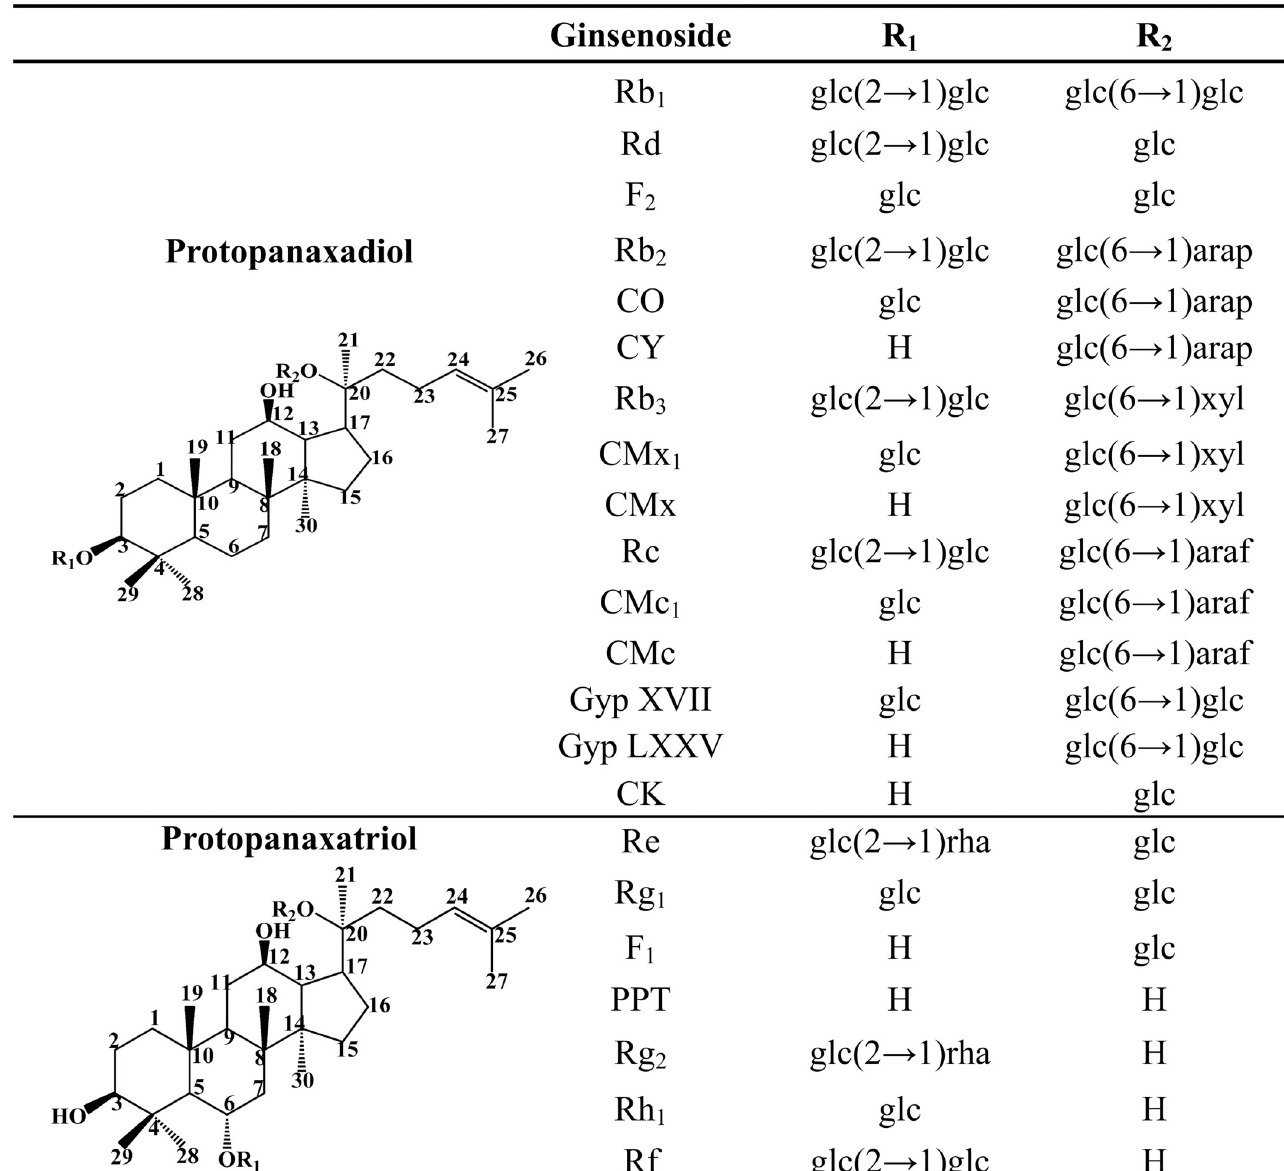
Fig 1. The chemical structural formula of ginsenosides. Glc, β -D-glucopyranosyl; arap, α -L-arabinopyranosyl; xyl, β -D-xylopyranosyl; araf, α -L- arabinofuranosyl; rha, α -L-rhamncpyranosyl; Gyp, gypenoside; C, compound.